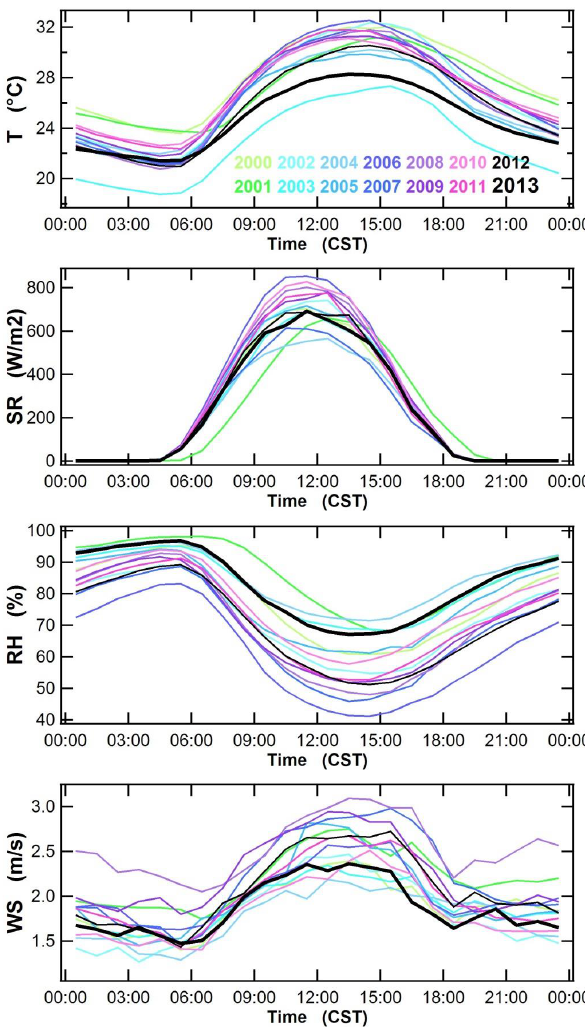
Figure 12. Mean diurnal hourly (CST) temperature ( T ), solar radi- ation (SR), relative humidity (RH), and wind speed (WS) at CTR from 1 June through 15 July each year, 2000-2013.